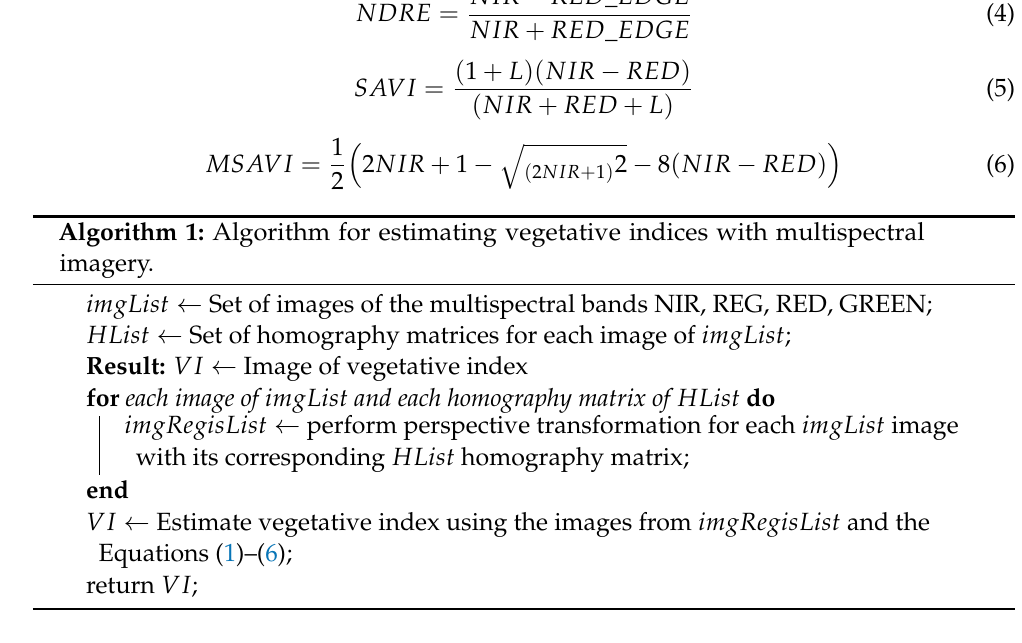
Figure 6. Behavior of the LiDAR’s lasers when they hit the edges of an object and another object is behind it.